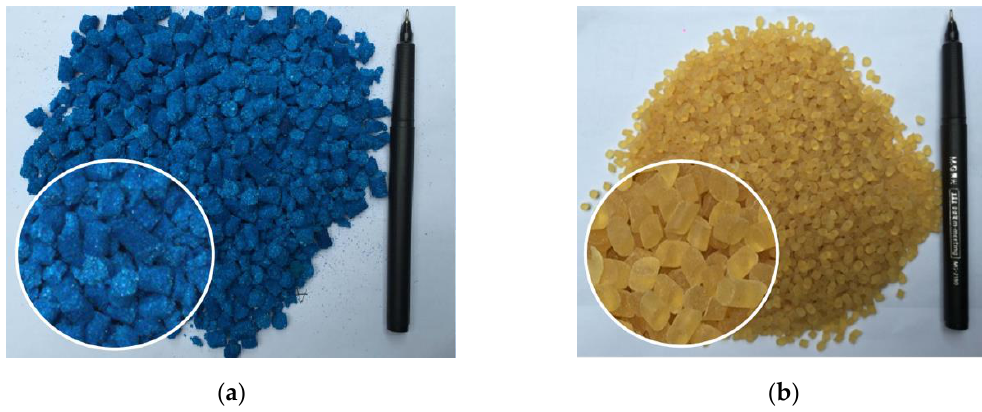
Figure 1. High-viscosity modifiers: ( a ) Type I high-viscosity modifier; ( b ) Type II high-viscosity Figure1. High-viscositymodifiers: ( a )TypeIhigh-viscositymodifier; ( b )TypeIIhigh-viscositymodifier. modifier. Table 4. Properties of high-viscosity Table 4. Properties of high-viscosity modifiers.